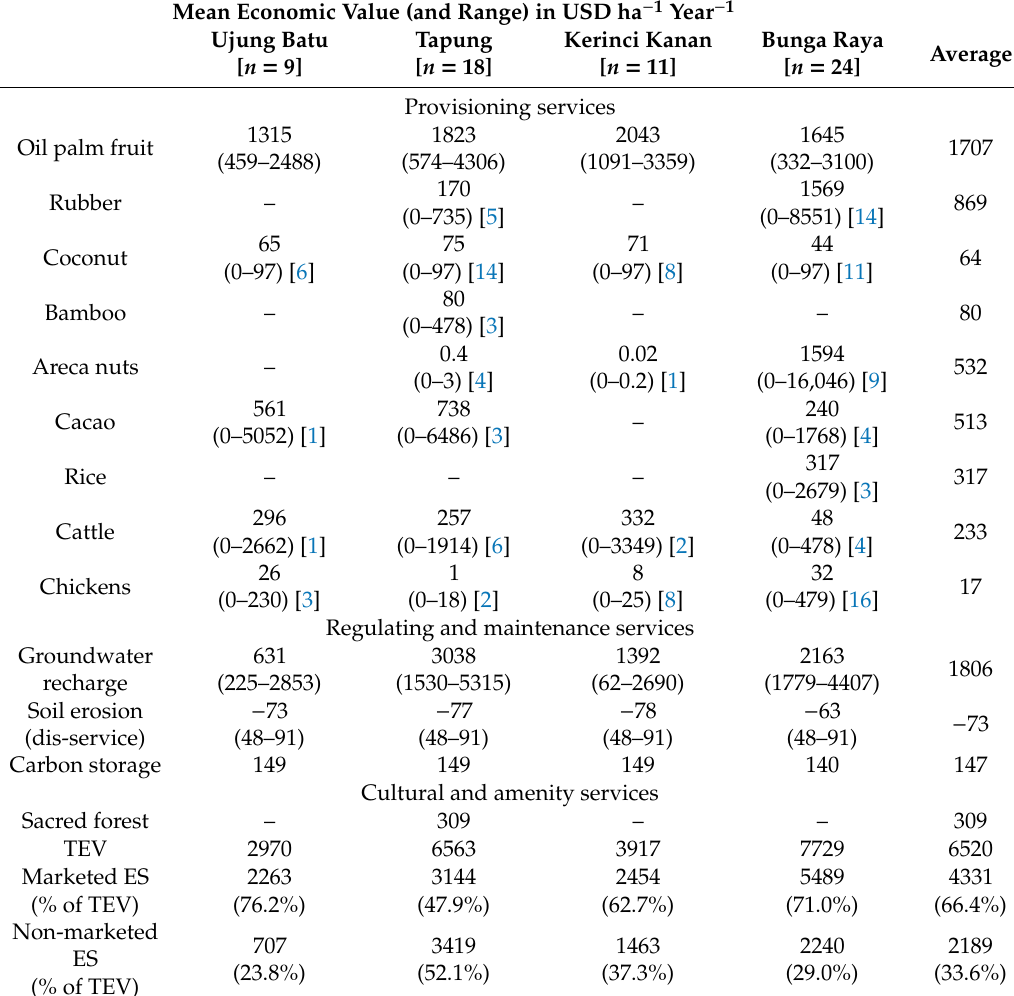
Table 3. Potential mean total economic value (TEV) of selected ecosystem services (ES) in Bunga Raya, Kerinic Kanan, Tapung, and Ujung Batu (USD ha − 1 year − 1 ). Numbers in square parentheses are the numbers of households growing these crops or rearing these